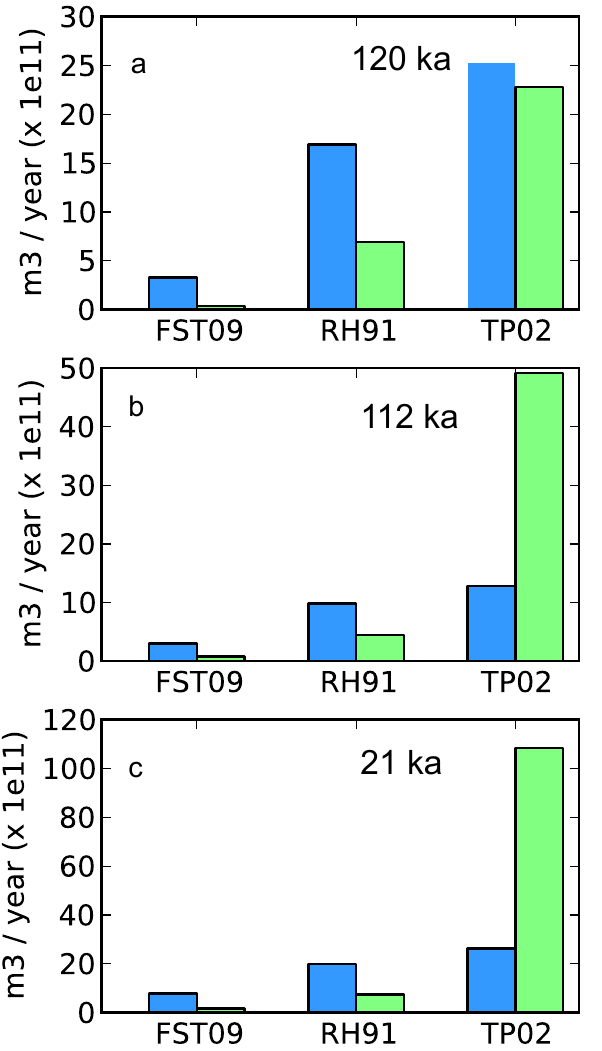
Fig. 4. Amounts of ablation (blue) and refrozen ice (green) given in m 3 yr − 1 computed with the three PDD models for 120 (a) , 112 (b) and 21ka (c) . These amounts are calculated for the same ice-sheet surface given by the FST09 standard simulation (run